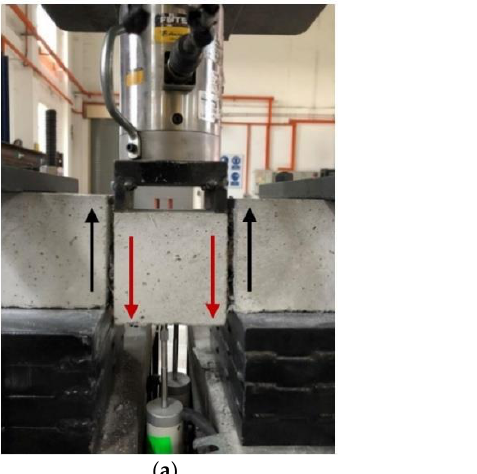
Figure 9 . The shear energy comparison for ( a ) HyFRC specimens and ( b ) single-fiber FRC specimens.